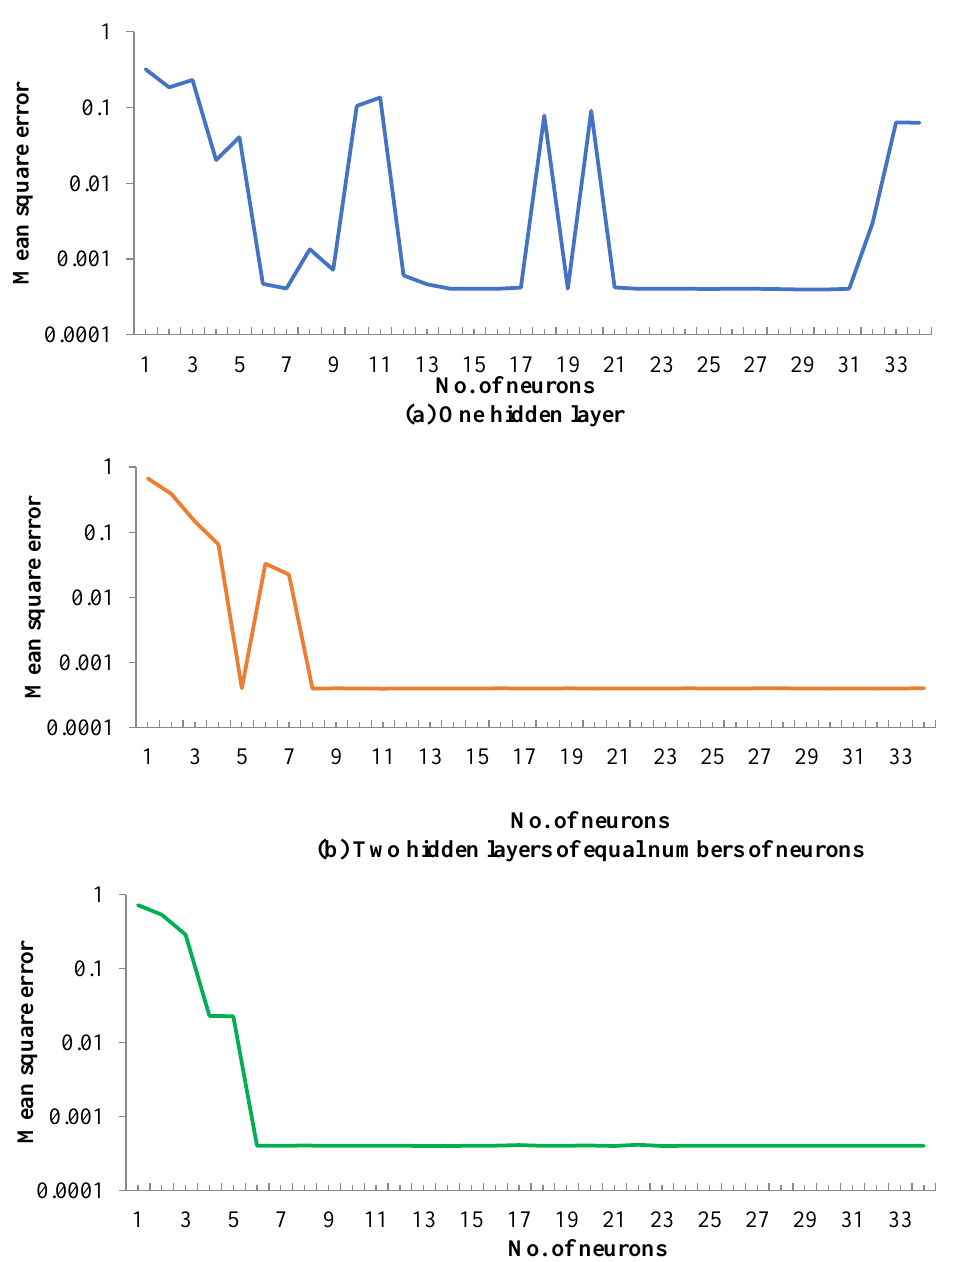
(c) Three hidden layers of equal numbers of neurons Figure 2. Mean square error achieved for ( a ) one hidden layer, ( b ) two hidden layers and ( c ) three hidden layers. The optimum neural network topology (36–10–10–10–34) is plotted as shown in Figure 3, this topology having 36 neurons in the input layer, 10 neurons for each one of three hidden layers, and 34 neurons in the output layer.